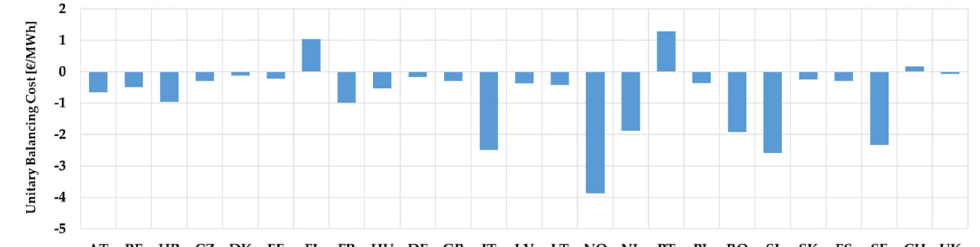
Figure 10. Unitary balancing cost of end-consumers in each participating control area.